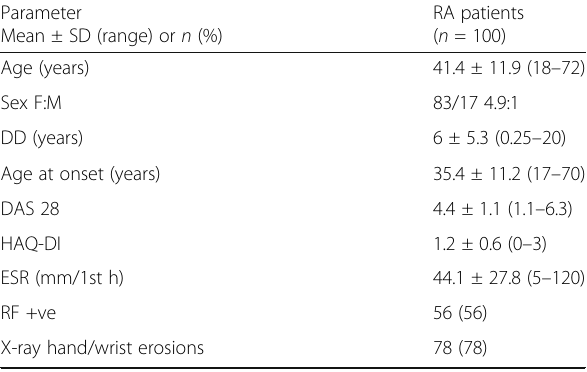
Table 1 Characteristics of the rheumatoid arthritis patients Parameter Mean ± SD (range) or n (%)